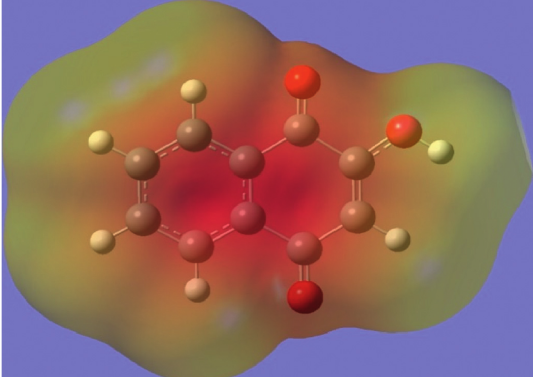
Figure 24: The molecular electrostatic potentials of the optimized structure of